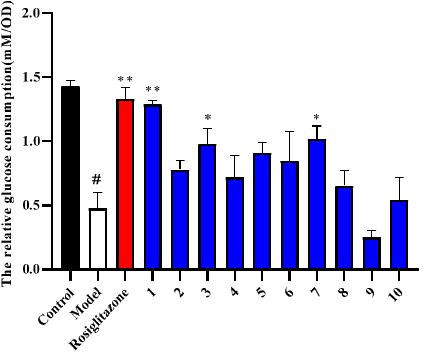
Figure 5. Effect of compounds 1 – 10 on the relative glucose consumption in insulin-induced HepG2 cells ( 𝑥̅ ± s, n = 4). The impact of compounds 1 – 10 on the relative glucose consumption measured by a glucose assay kit. # p < 0.05, versus control group; * p < 0.05 or ** p < 0.01, versus insulin group. Table 3. Effect of compounds 1 , 3 , and 7 on the relative glucose consumption in insulin-induced HepG2 cells ( x ± s, n =